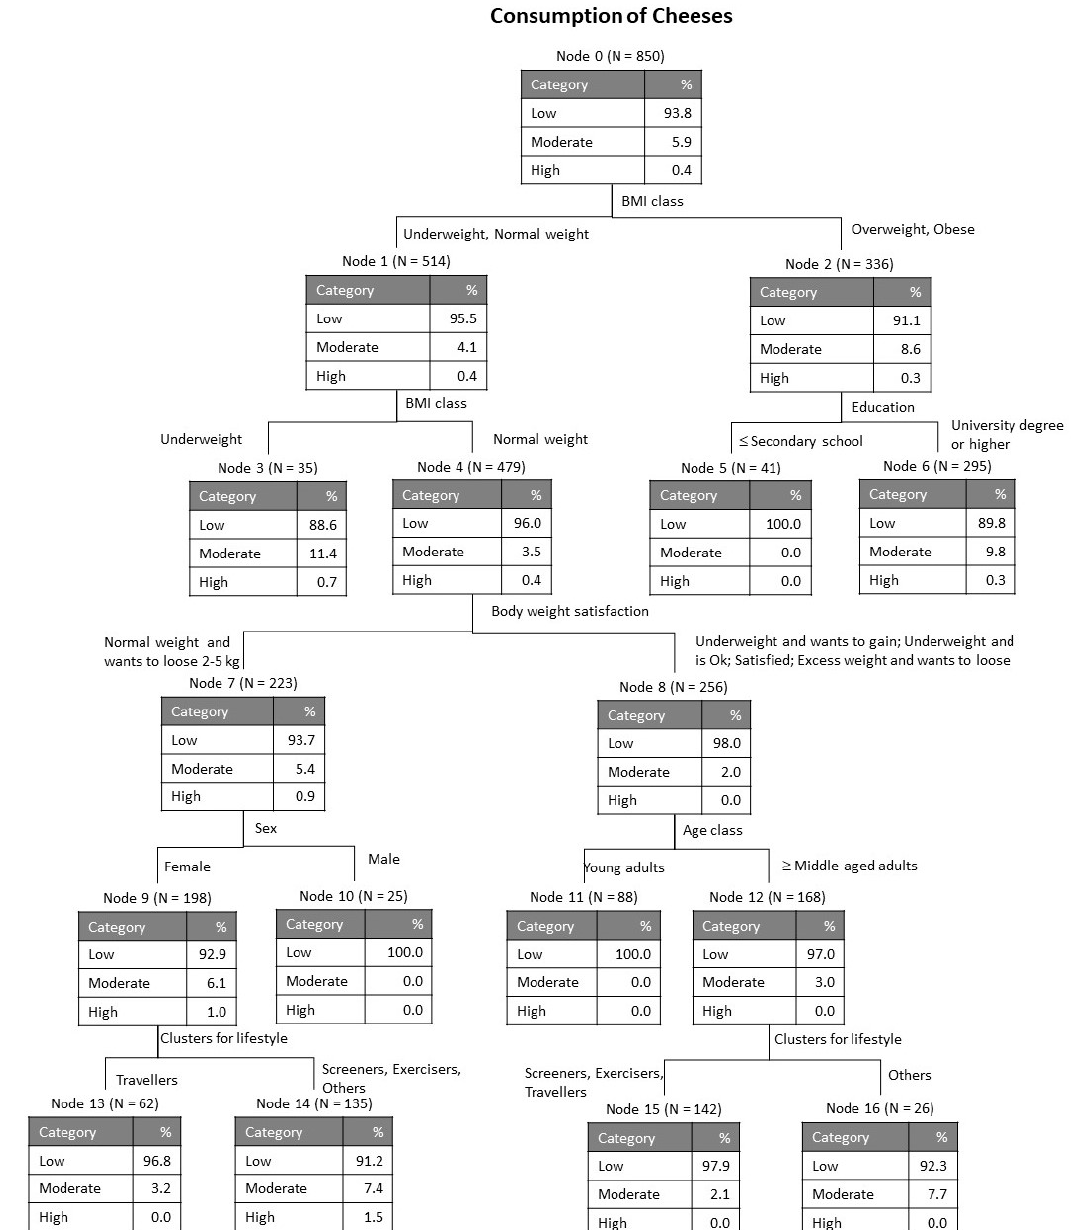
Figure 2. Tree classification for consumption of cheeses.